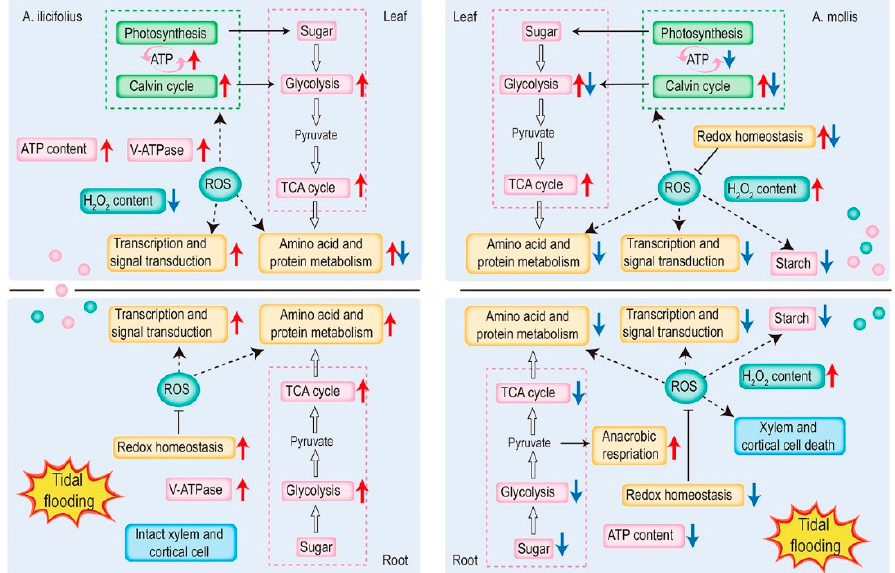
Figure 9. A schematic representation of A. ilicifolius and A. mollis response and adaptation strategies to tidal flooding stress. Red arrows, up-regulated; blue arrows, down-regulated; pink, the energy-producing pathway and storage substance; orange, biological metabolism that requires energy; green, the pathways in chloroplast. Pink circle, the transport of energy and sugar from leaves to roots; cyan circle, the transport of H 2 O 2 .